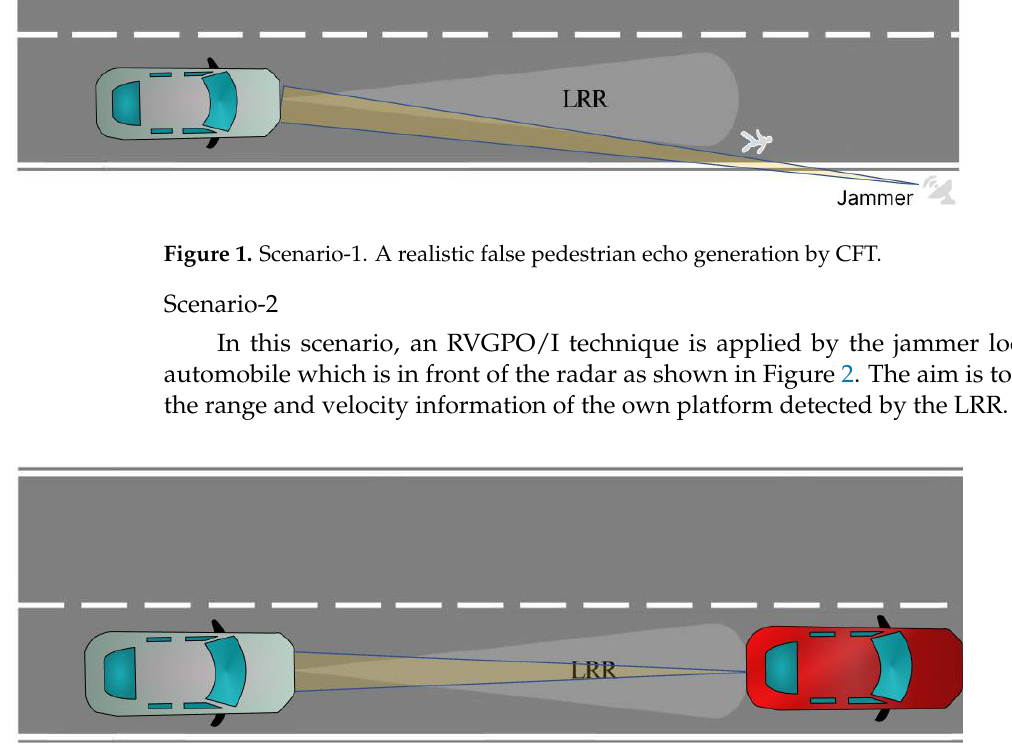
Figure 2. Scenario-2. An RVGPO/I technique for spoofing. Scenario-3